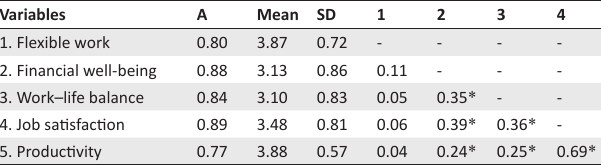
TABLE 2: Descriptive statistics ( n = 252) and correlation analysis. Variables